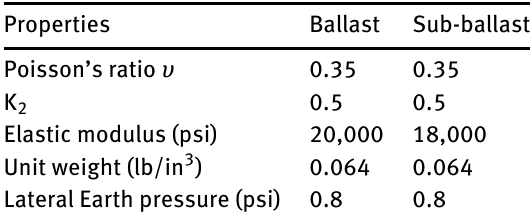
Table 9: Properties of ballast and sub-ballast.